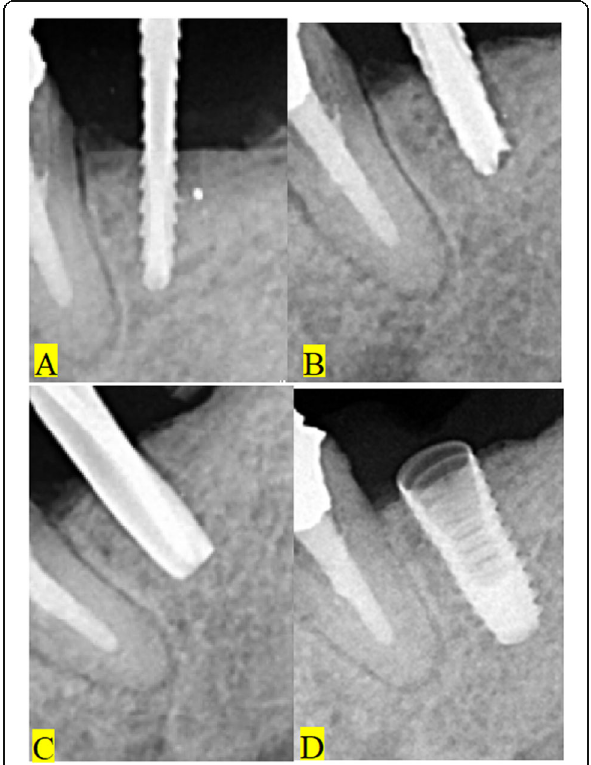
Fig. 5 A case showing how to handle the problem of the presence of a radiopacity at the implant site. a Initial drilling showing the radiopacity near the small drill. b Preparation with a larger drill to include the site of the radiopacity. c The final drill is including the radiopacity site. d The implant fixture in place with no evidence for the presence of any radiopaque